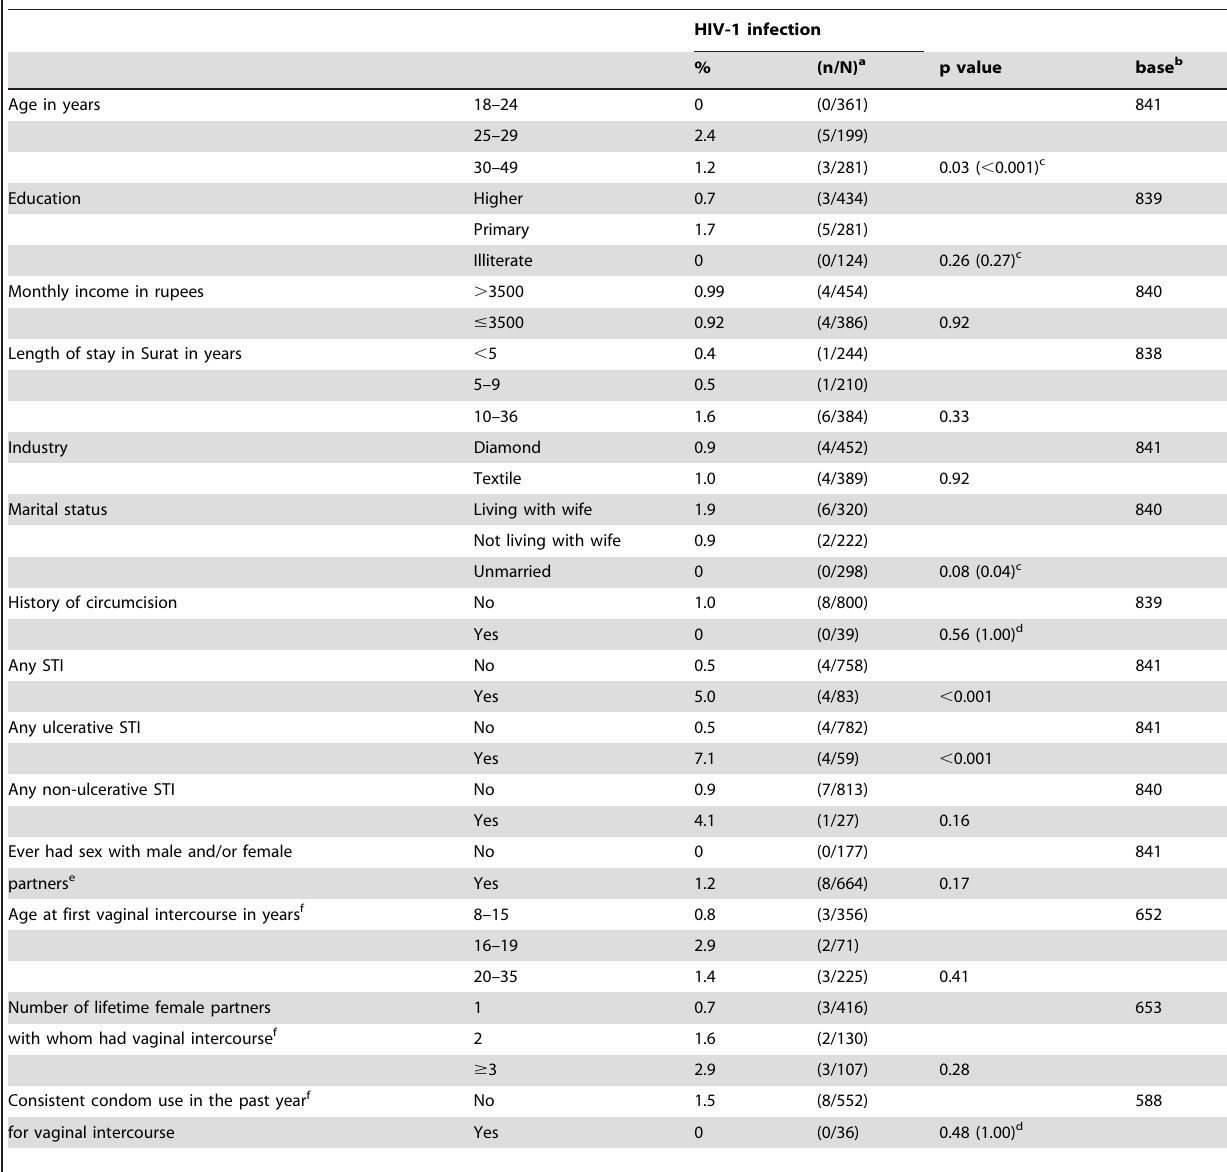
Table 3. Association of determinants with HIV-1